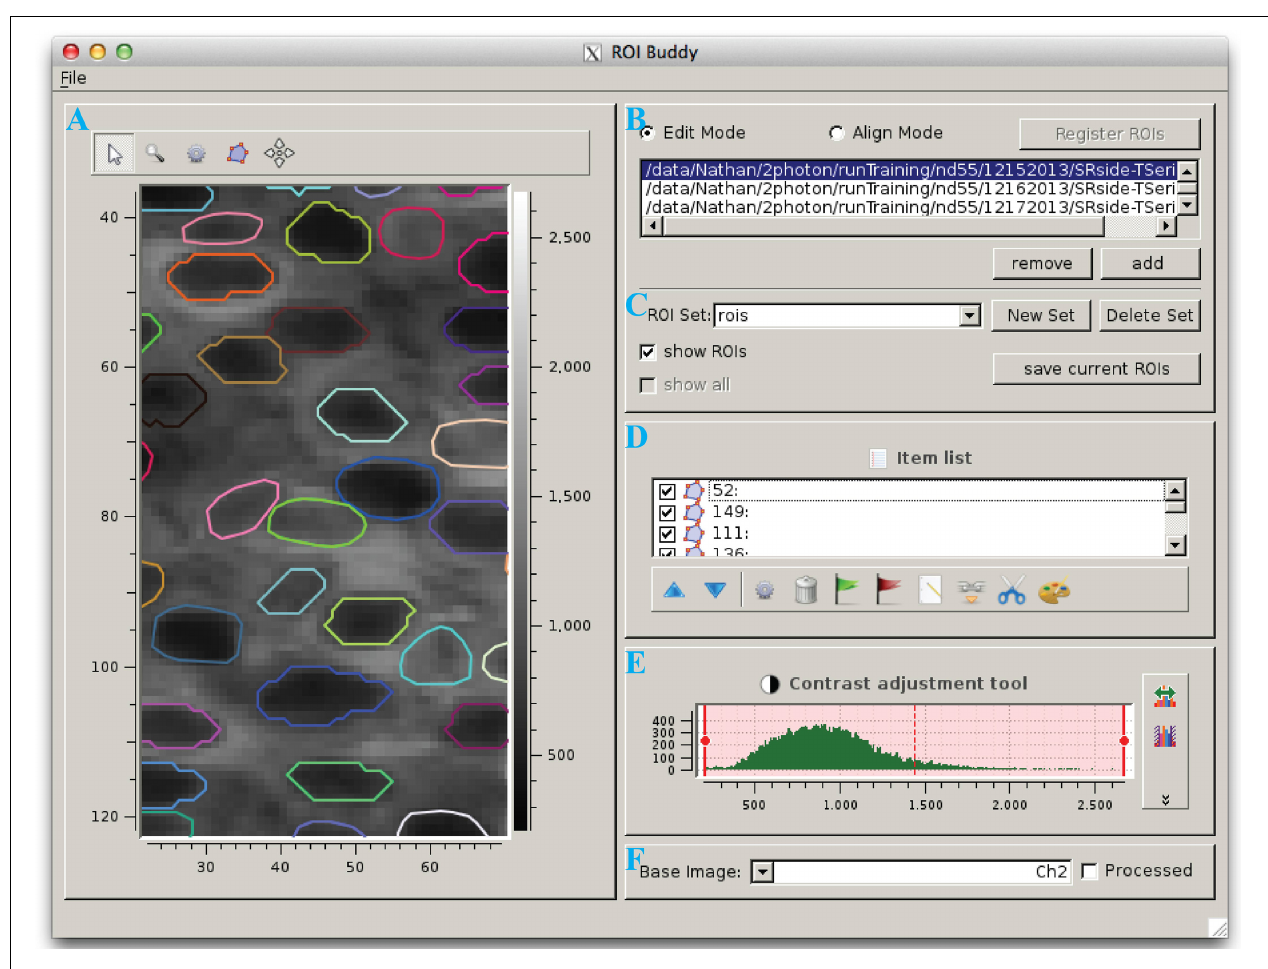
FIGURE 3 | The ROI Buddy graphical user interface. (A) Image viewing panel with ROI editing tools. During typical use this panel is expanded to occupy the majority of the screen. (B) Panel for toggling between “Edit” and “Align” modes, loading imaging datasets, and registering ROIs across datasets. (C) Panel for selecting, creating, saving, and deleting sets of ROIs